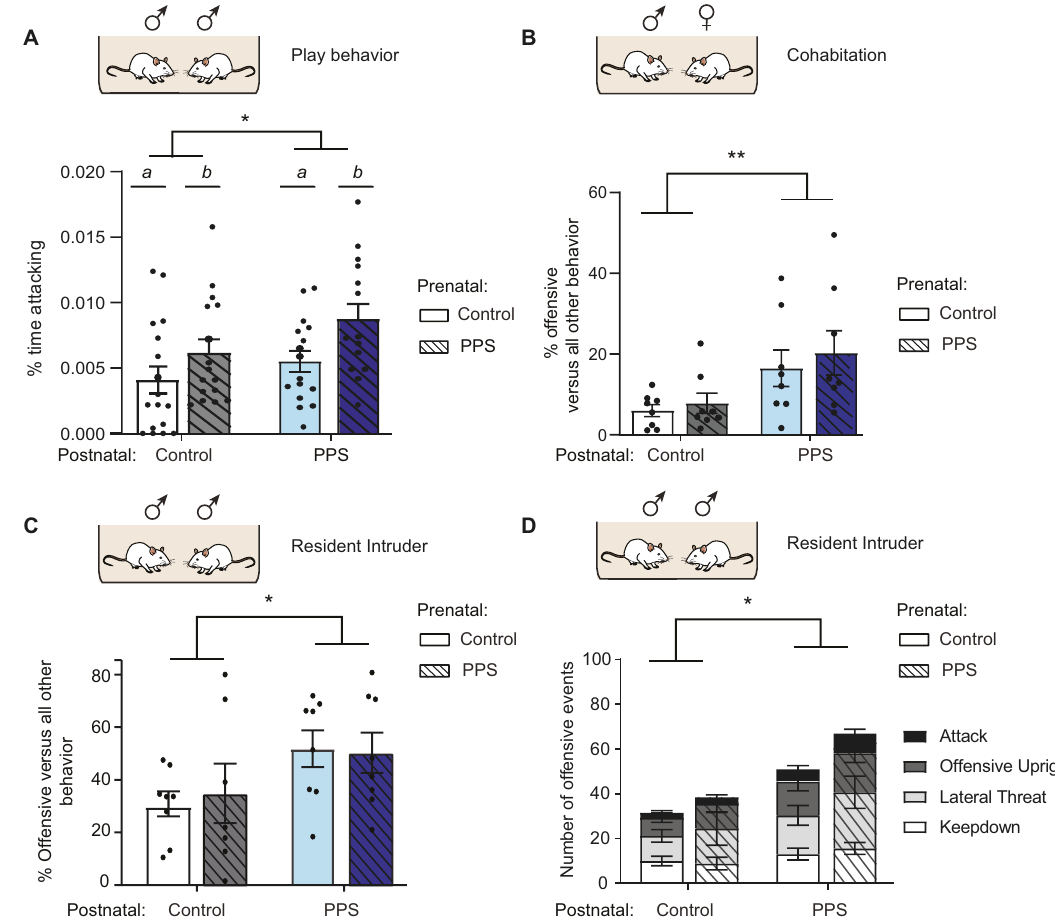
Fig. 2 Postnatal environment explains aggressive tendencies in F1 males. A Play behavior. In juveniles, aggressive temperament was enhanced during home cage play behavior as a result of both prenatal and postnatal PPS dam in fl uences. Prenatal effects are depicted by letters a, b. B Cohabitation. Only the adults reared by PPS male-paired dams exhibited increased aggressive behavior towards females during cohabitation. C Resident-intruder test. Adults reared by PPS male-paired dams exhibited increased aggressive behavior towards an intruder male as evidenced through increased proportion of offensive behaviors compared to all other behaviors. D Increased aggression in males reared by PPS male-paired dams was also measured in terms of the number of offensive events. The results are the mean ± s.e.m. PPS: Peripubertally stressed rats. * P < 0.05, ** P <